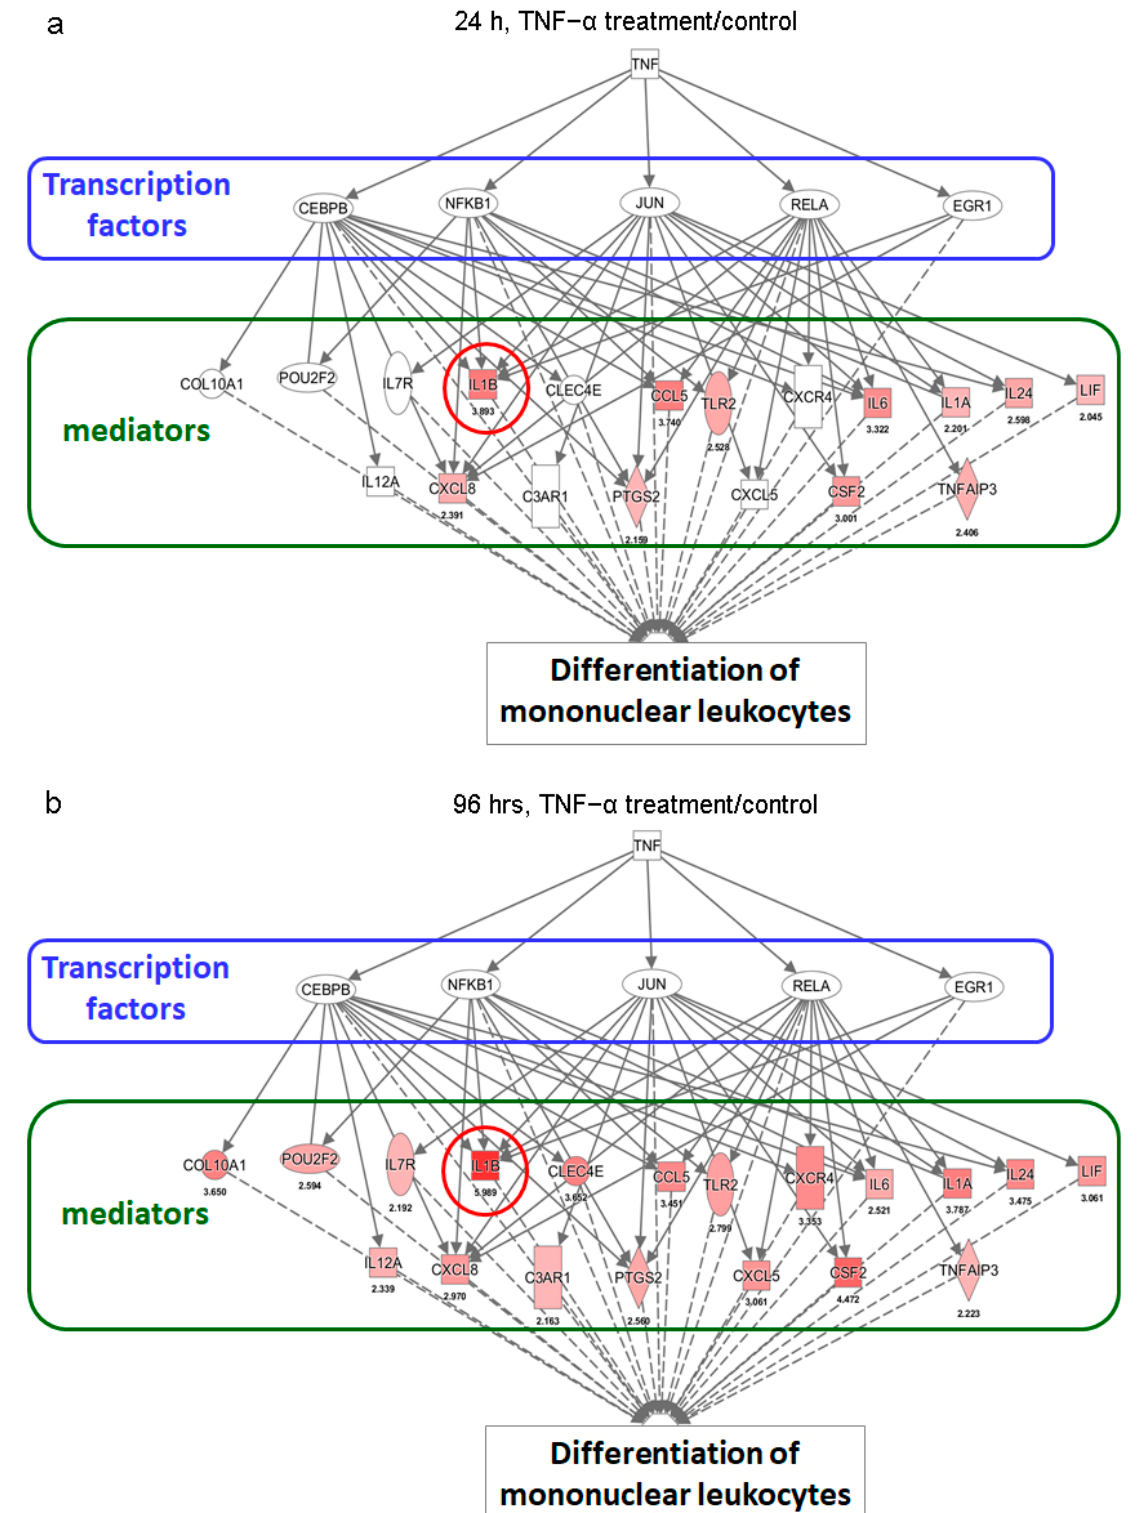
Figure 5. Leukocyte differentiation-related pathways in ADSCs involving putative signaling networks of CEBPB-, NFKB1-, JUN-, RELA-, and EGR1-mediated transcriptional activities in response to TNF- α stimulation for 24 ( a ) and 96 h ( b ), proposed using the Ingenuity software (Qiagen, Hilden, Germany). The red circles indicate changes in IL-1B expression levels in the TNF- α -induced signaling network. The number under each symbol indicated on the maps is the ratio fold change between the treatment and control groups.